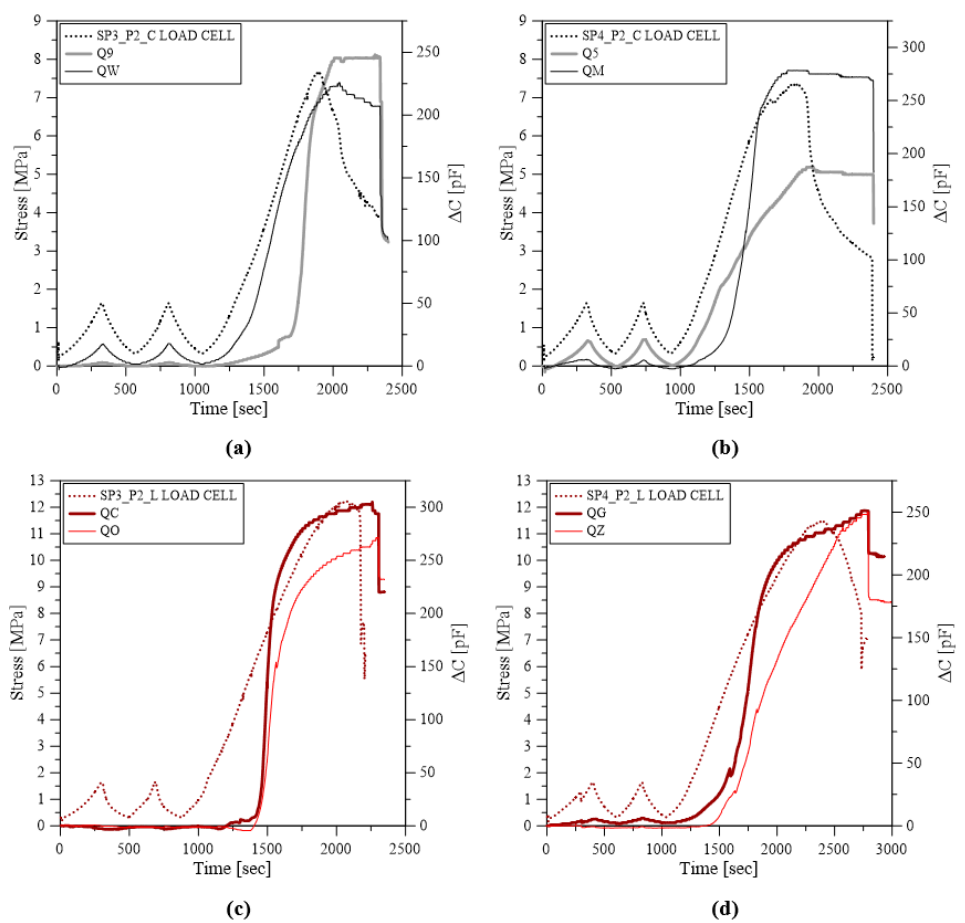
Figure 18. Comparison of outcomes from capacitive sensor and load cell, for post-installation system P2: ( a , b ) calcarenite masonry; ( c , d ) clay brick masonry.